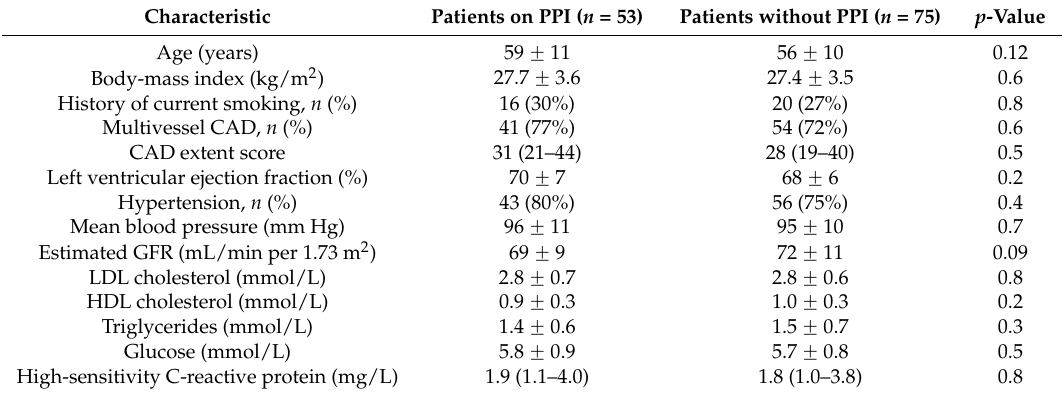
Table 1. Characteristics of CAD patients according to PPI use prior to admission on a background of concomitant low-dose aspirin, ACEI and